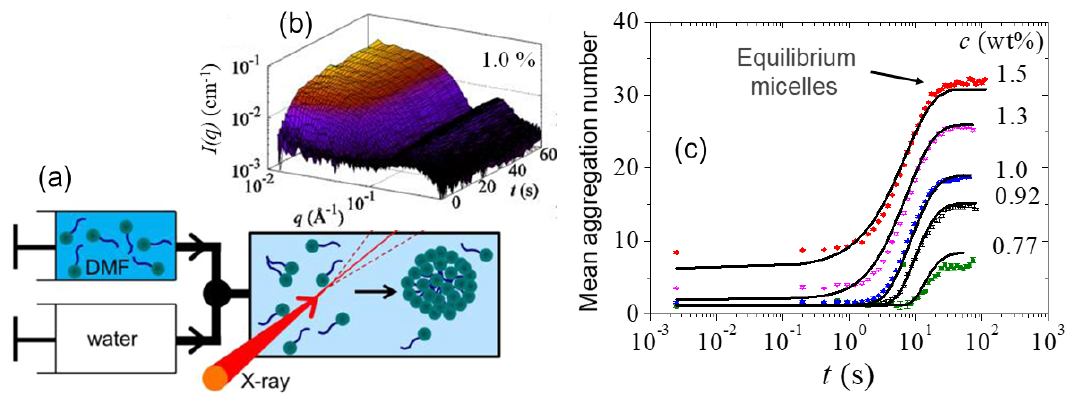
Figure 10. Nucleation and growth of surfactant (dodecyl maltoside) micelles from a solution of monomers in dimethylformamide (DMF) upon mixing with water. ( a ) Schematic drawing of the stopped-flow mixing device and the scattering cell with surfactants. ( b ) Time evolution of the SAXS intensity during the nucleation and growth process for 1 wt% solution. ( c ) Time evolution of the mean aggregation number derived from the modeling of SAXS intensities for different surfactant concentrations. The continuous lines show the good agreement with nucleation and growth